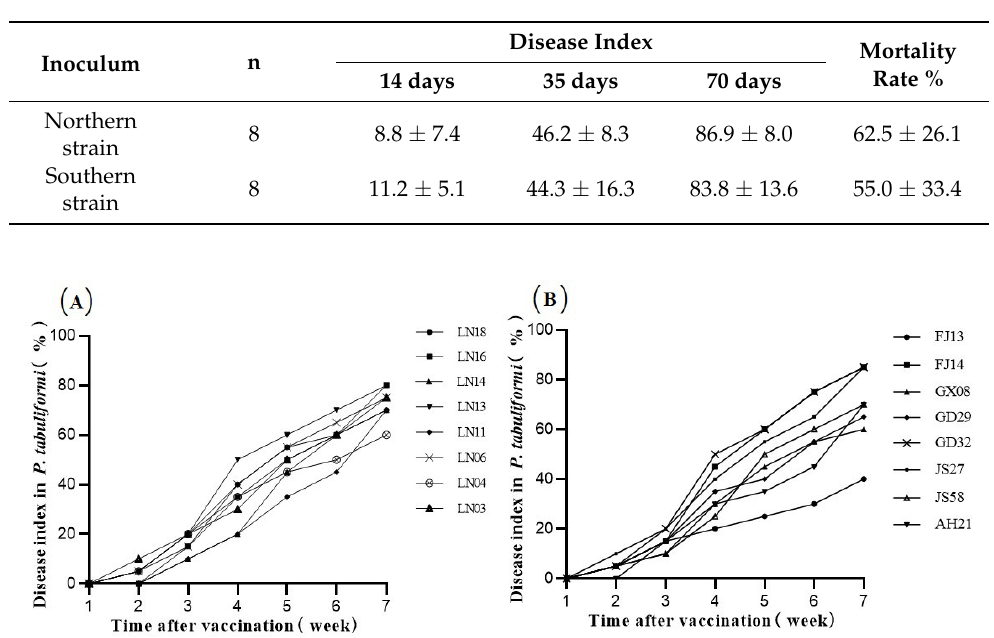
Table 7. Disease index and mortality of P. tabuliformis inoculated with northern and southern PWN strains.